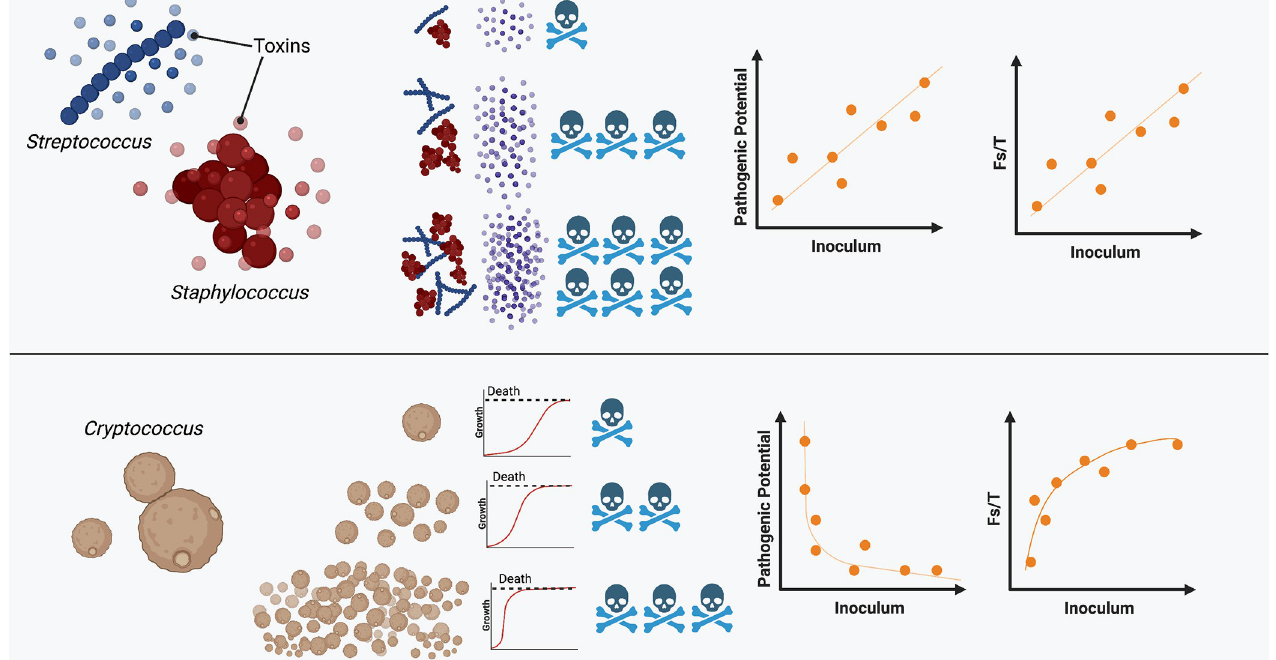
Fig 10. Model for how differing mechanisms of microbial pathogenesis affect PP vs I and Fs/T relationships. The top panel indicates microbes, such as Streptococcus and Staphylococcus that produce toxins that have a dose-dependent effect on survival. This results in positive PP vs. I and a positive linear Fs/T vs I relationships. In the bottom panel is Cryptococcus which has an exponential negative relationship with PP vs. I and a logarithmic positive relationship with Fs/ T vs. I, which we propose is because Cryptococcus causes host death through fungal burden, which would be a log-based relationship between starting inoculum and disease, rather than a dose-dependent linear